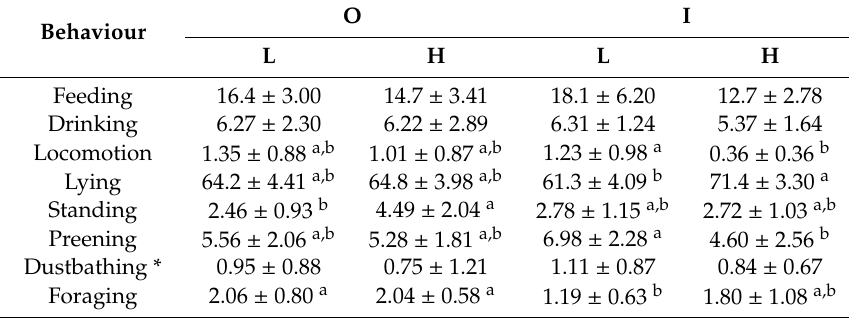
1 Percentage of time performing each behaviour based on a total of 210 min of observation. O = Outdoor access; I = Indoors; L = Low stocking density; H = High stocking density. LS Means in the same row with different superscript letters indicate statistically significant differences (Tukey’s HSD test; p ≤ 0.05). * Square root transformed for ANOVA. LS Means provided were calculated from